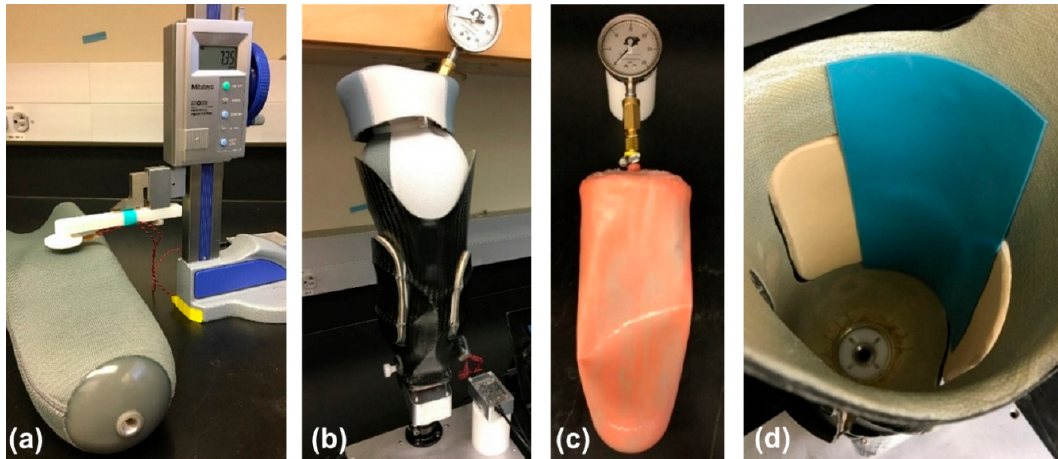
Figure 3. Calibration systems: ( a ) benchtop calibration system consisted of a sensor fastened to the arm of a vertical height gauge. A high-resolution measurement was obtained from a single location on the liner. ( b ) Complete in-socket calibration system with the bladder and liner expanded to force the liner to conform to socket wall while data were collected. ( c ) Bladder used to expand the liner. ( d ) Flexible offset pieces were adhered to the socket wall to measure sensor response at multiple liner–antenna distances.